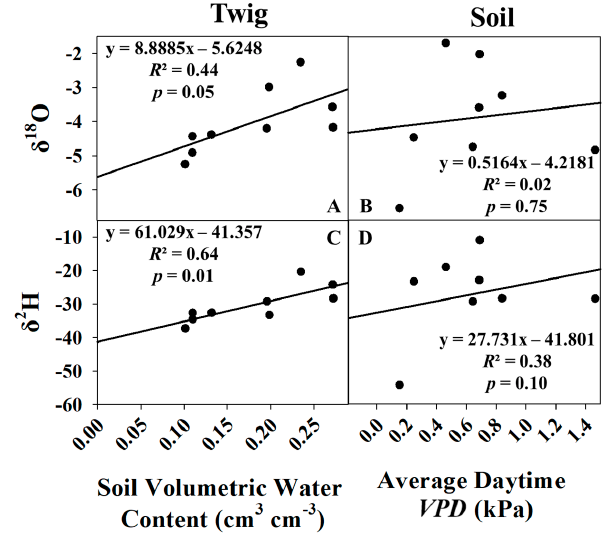
Figure 9. Linear regressions of δ 18 O vs. average soil moisture ( A ) and average daytime VPD ( B ), δ 2 H vs. average soil moisture ( C ), and average daytime VPD ( D ) for the growing season and dormant season combined.